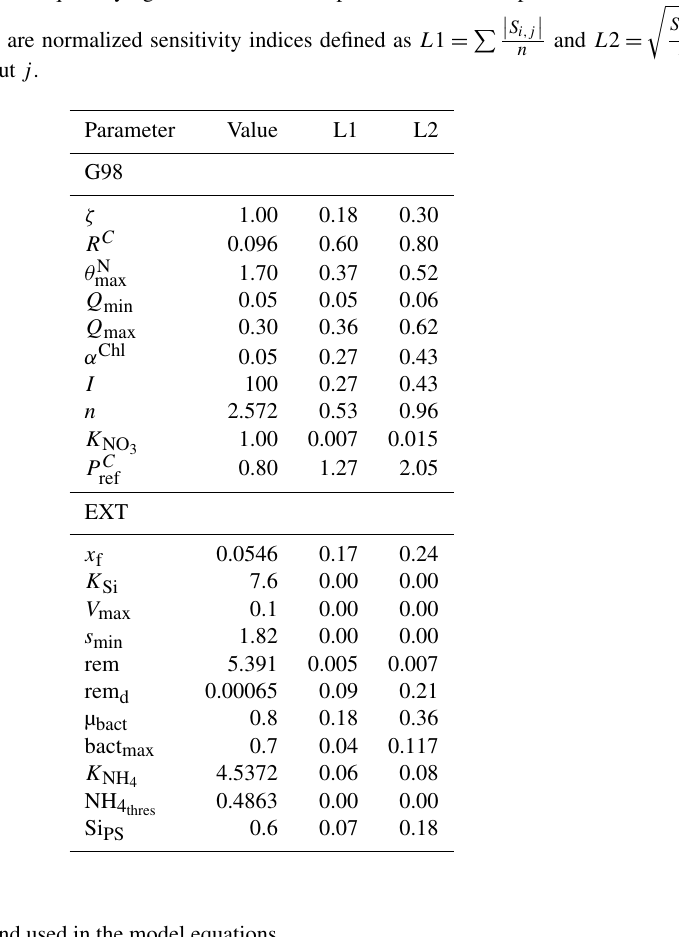
(cid:114) (cid:12) (cid:12) S 2 i,j (cid:12) S i,j (cid:12) and L 2 = , with S i,j being the n n